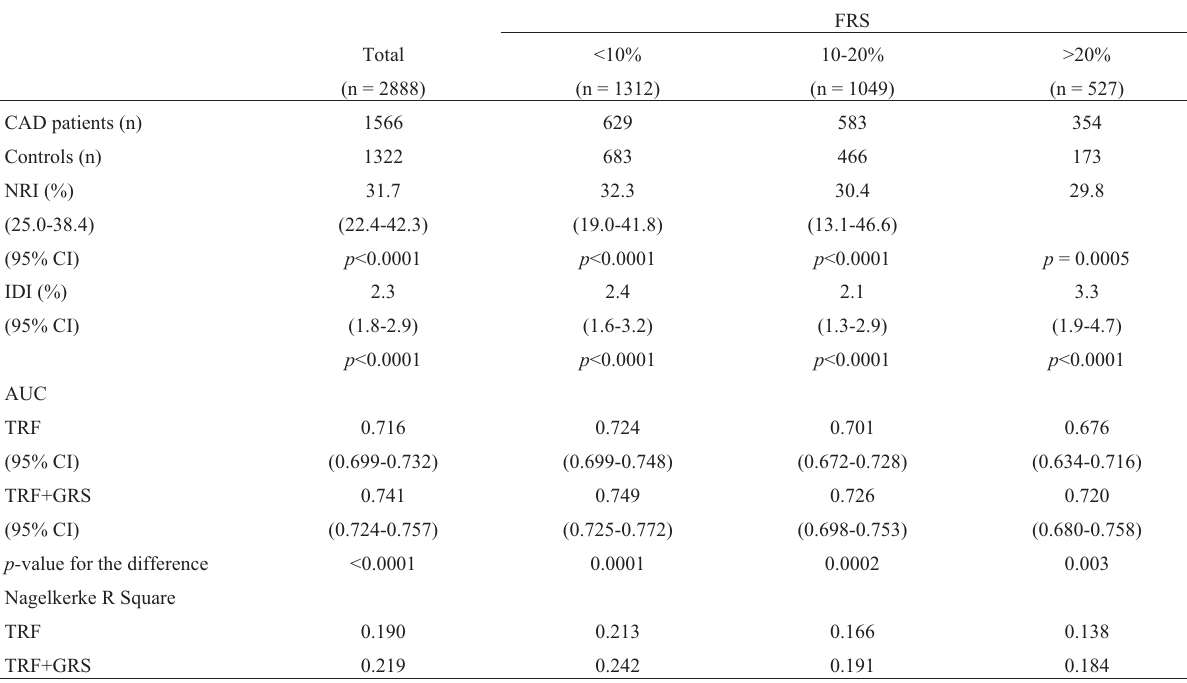
Table 3 - Reclassification table comparing predicted CAD risk with and without